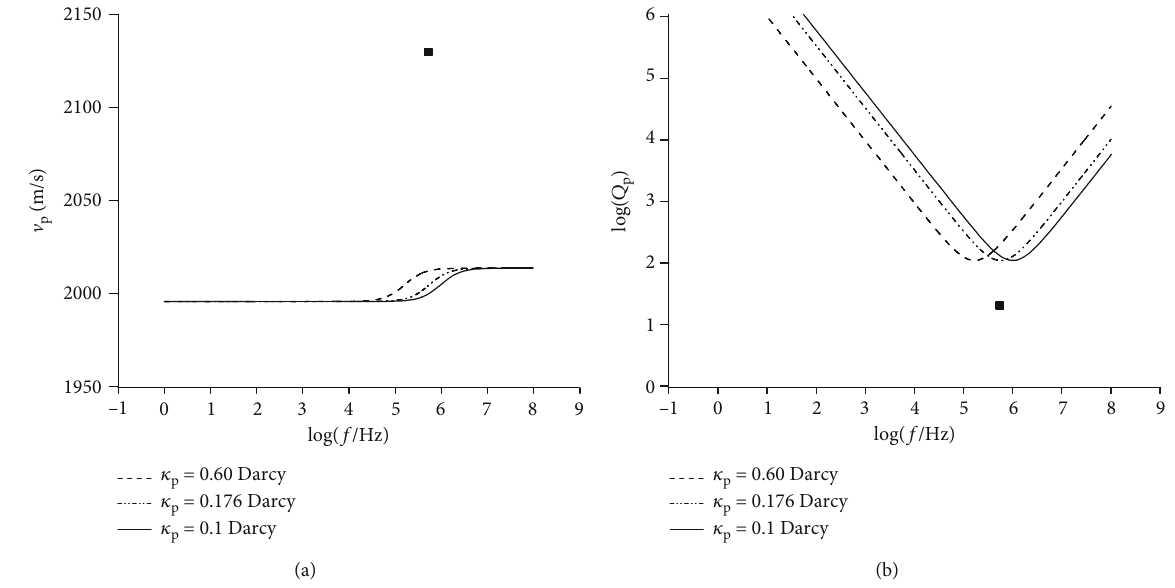
Figure 3: Same as Figure 2 except for compressed glass beads, with Darcy permeability being 0.60